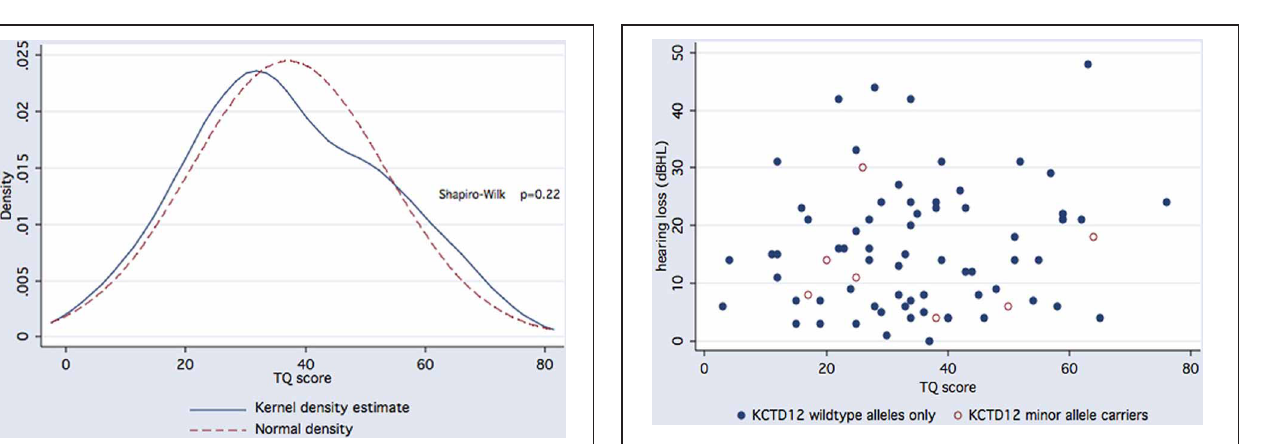
FIGURE 1 | Distribution of TQ scores in 144 subjects with chronic tinnitus does not deviate from the expected Gaussian curve ( p = 0 . 22).